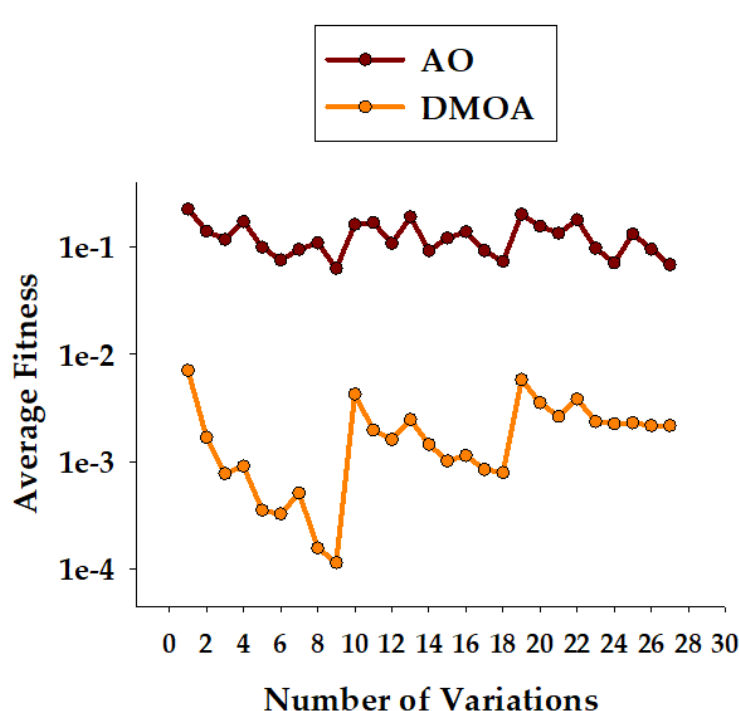
Figure 10. Kruskal – Wallis test between the DMOA and RSA, where p < 0.01.